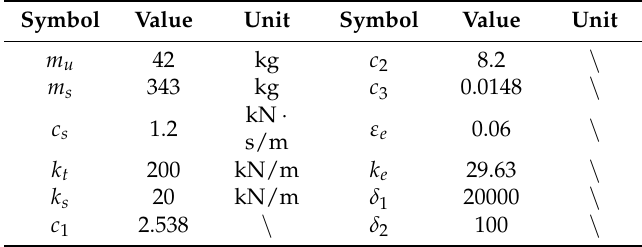
Table 3. The actual parameters of the quarter suspension system.